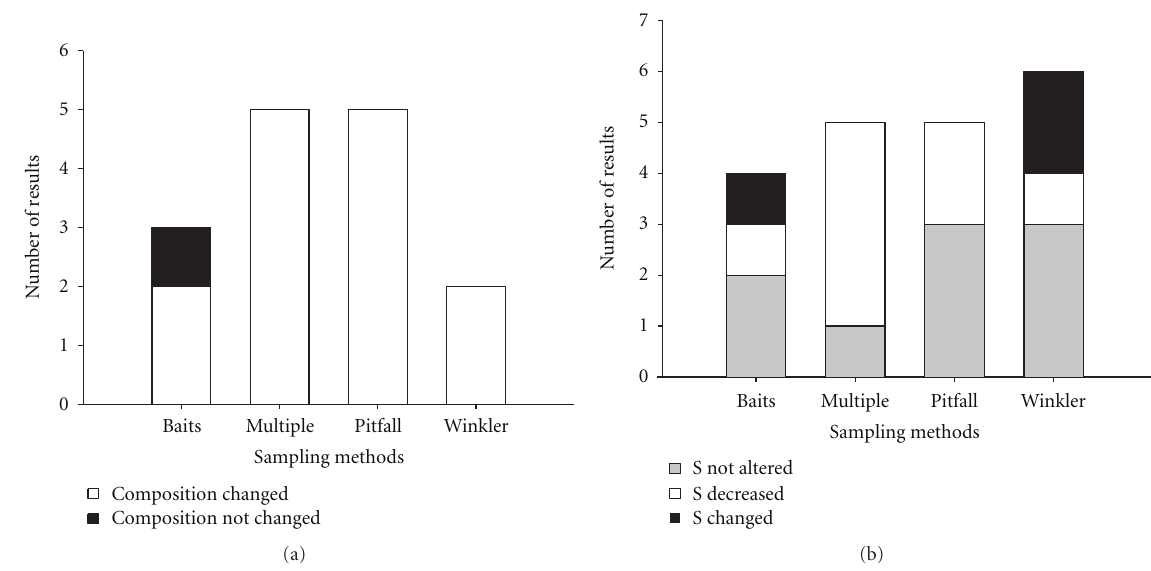
Figure 3: Papers that analyzed (a) ant species composition and/or (b) ant species richness/diversity with statistical tests and their responses to habitat disturbance through the use of di ff erent ant sampling methodologies. Composition changed—species composition altered by disturbance. Composition not changed—species composition not altered by disturbance. S increased—species richness or diversity increased with disturbance. S not altered—species richness or diversity not a ff ected by disturbance. S decreased—species richness or diversity decreased with disturbance. S changed—species richness or diversity changed with disturbance when there is any clear trend in the response of ants to